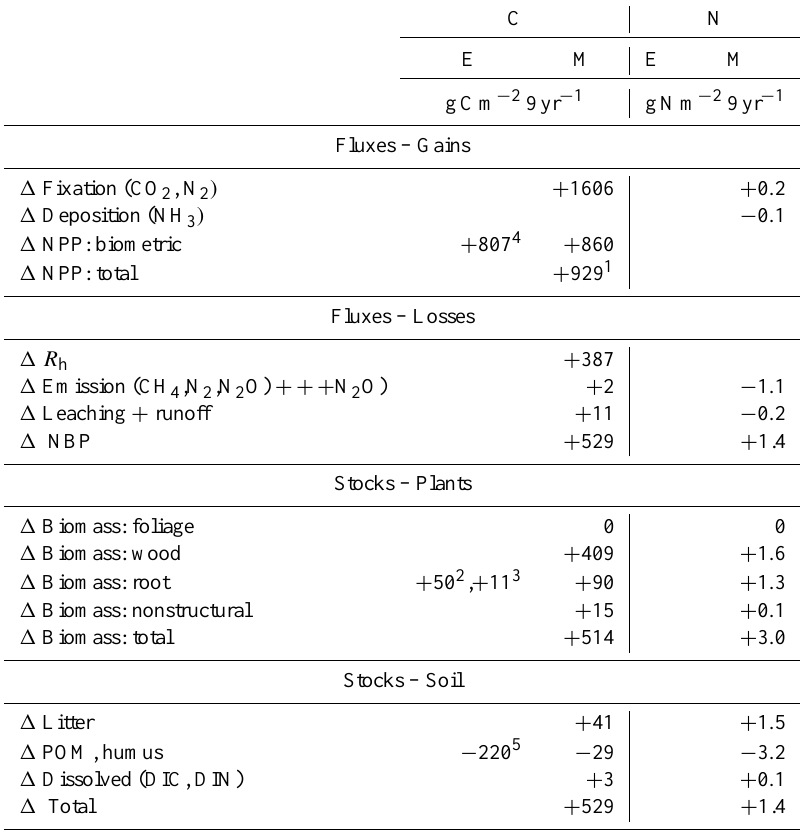
Table 3. Differences in cumulative fluxes and stocks of C and N estimated from biometric measurements (E) or modelled (M) at